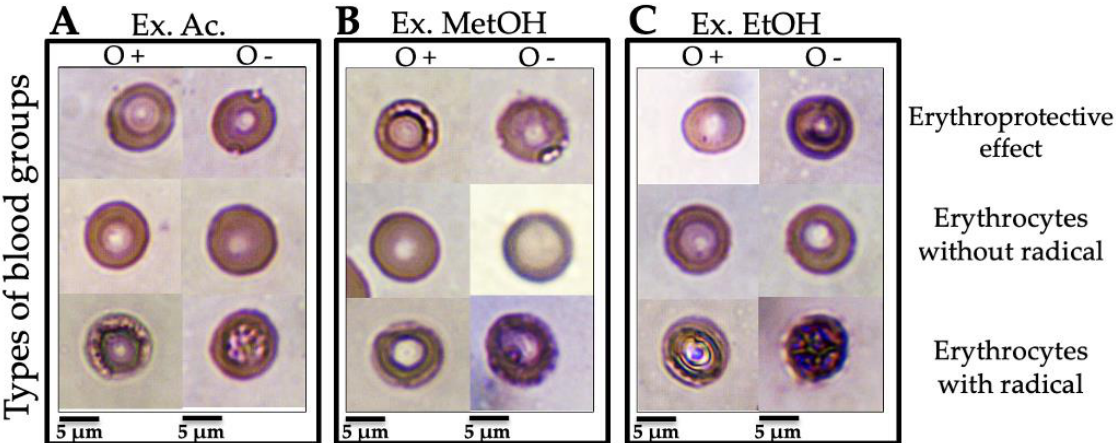
Figure 2. Micrographs of human erythrocytes (100 × ). Use of red blood cell membranes to evaluate the protective effect against oxidative damage from N. incerta extracts in different Rh (Rh+ and Rh − . Morphological change seen in micrography is caused by free-radical-Induced hemolysis (using AAPH molecule as a free radical generator). ( A ) Protective effect of the acetone extract (Ext. Ac.) of N. incerta on ABO blood groups. ( B ) Protective effect of the methanolic extract (Ext. MetOH.) of N. incerta on ABO blood groups. ( C ) Protective effect of the ethanolic extract (Ext. EtOH.) of N. incerta on ABO blood groups. Barr = 5 μm.